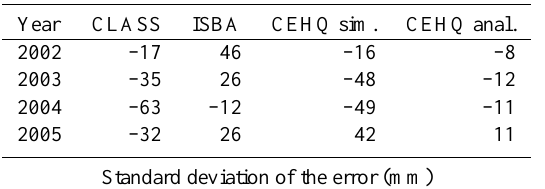
Table 1. Bias, standard deviation of the error, root mean square error and correlation coefficient of different SWE predictions for the Ottawa River basin Bias (mm)